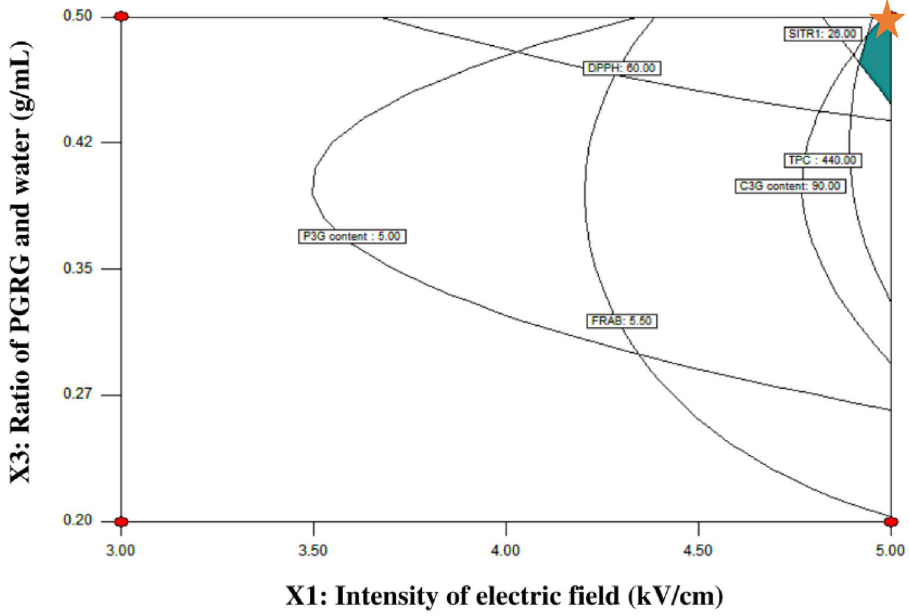
Figure 4. Response surface of optimized condition for PEF-AWE process with fixing number at pulse value of 3000 pulse.